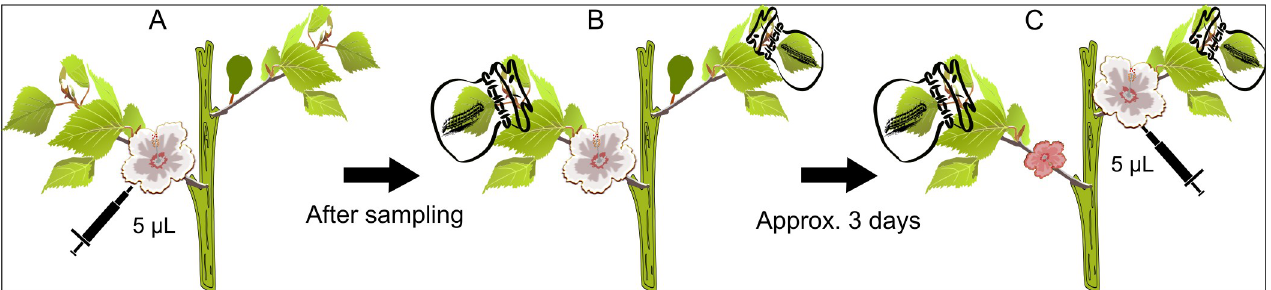
Fig 2. Experimental procedure for collecting constitutive and induced EF nectar samples. (A) A greenhouse plant of G . hirsutum on the day of anthesis for the first flower. A flower bud develops on the next branch. A total of 5 μ L EF nectar is collected from the three bracteal nectaries. This sample, collected prior to plant exposure to herbivory, is the constitutive sample. (B) Immediately following, the terminal leaf of the branch bearing the flower on the day of anthesis is enclosed with two S . exigua larvae using a draw-string organza bag. The terminal leaf of the next branch, the branch that would bear a flower on the day of anthesis in approx. three days, was enclosed similarly. (C) Another 5 μ L of bracteal EF nectar is collected from the second flower. This sample, collected after approx. 3 days of exposure to S . exigua , is the induced sample. The corolla of the flower from which the constitutive sample was collected has shriveled and turned pink, typical of G . hirsutum (see Fig 1B for